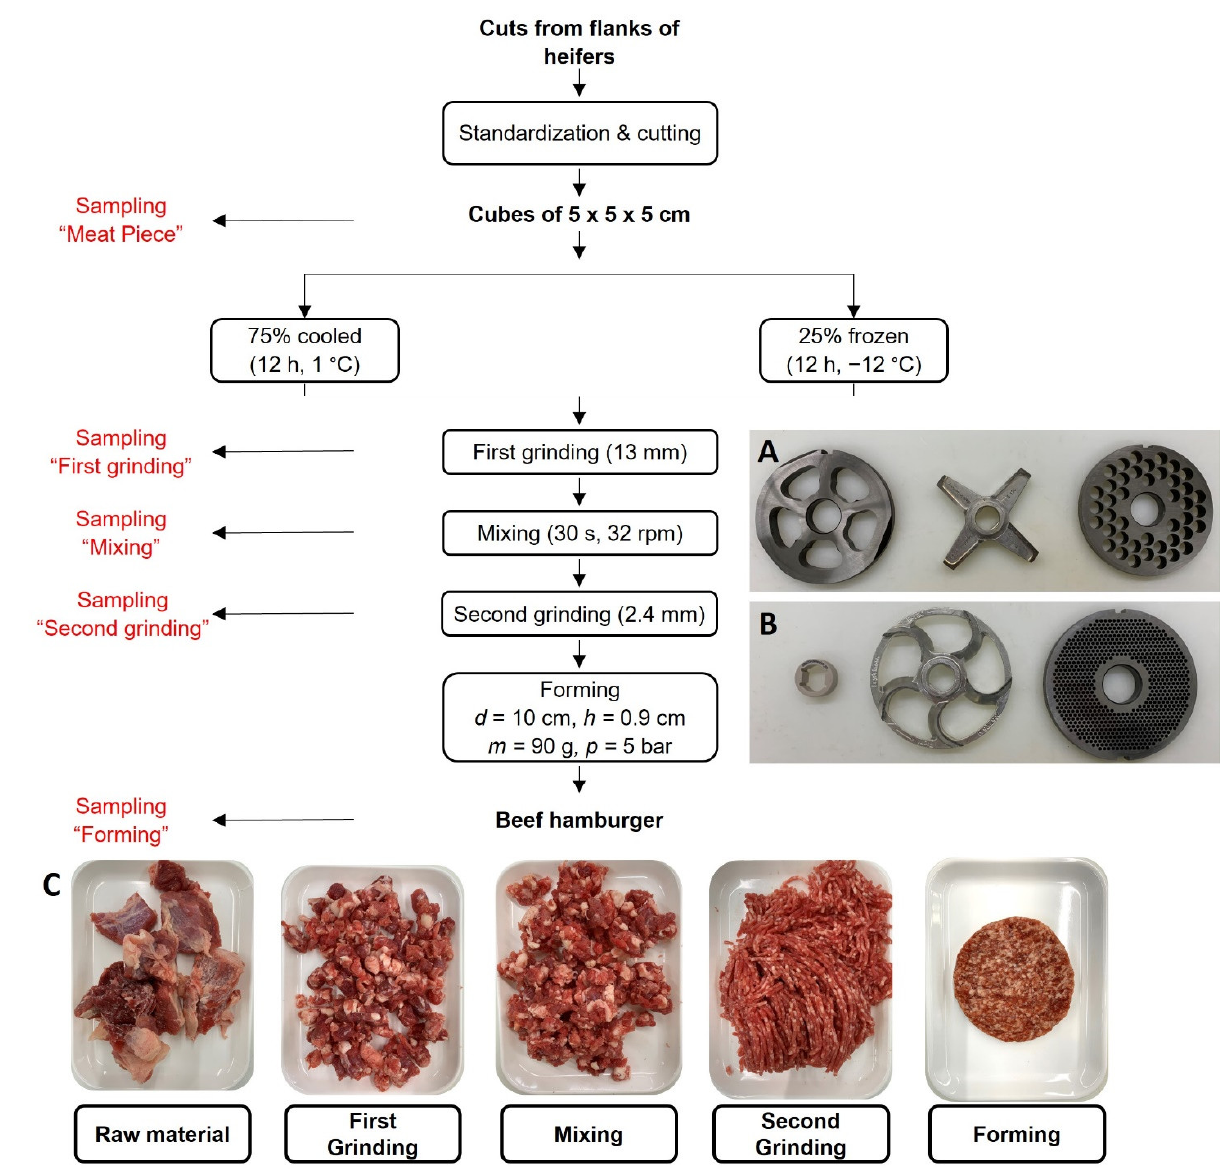
Figure 1. Flow chart of the hamburger manufacturing with different points of sampling, cutting set composition of ( A ) first grinding step (3-part cutting system: pre-cutter, 4-bladed knife, 13 mm inclined perforated disc) and ( B ) second grinding step (3-part cutting set: spacer, 5-bladed sickle knife, 2.4 mm inclined perforated disc) and photographs of the samples ( C ), n = 3. Table 1. Details on equipment used for hamburger manufacturing.